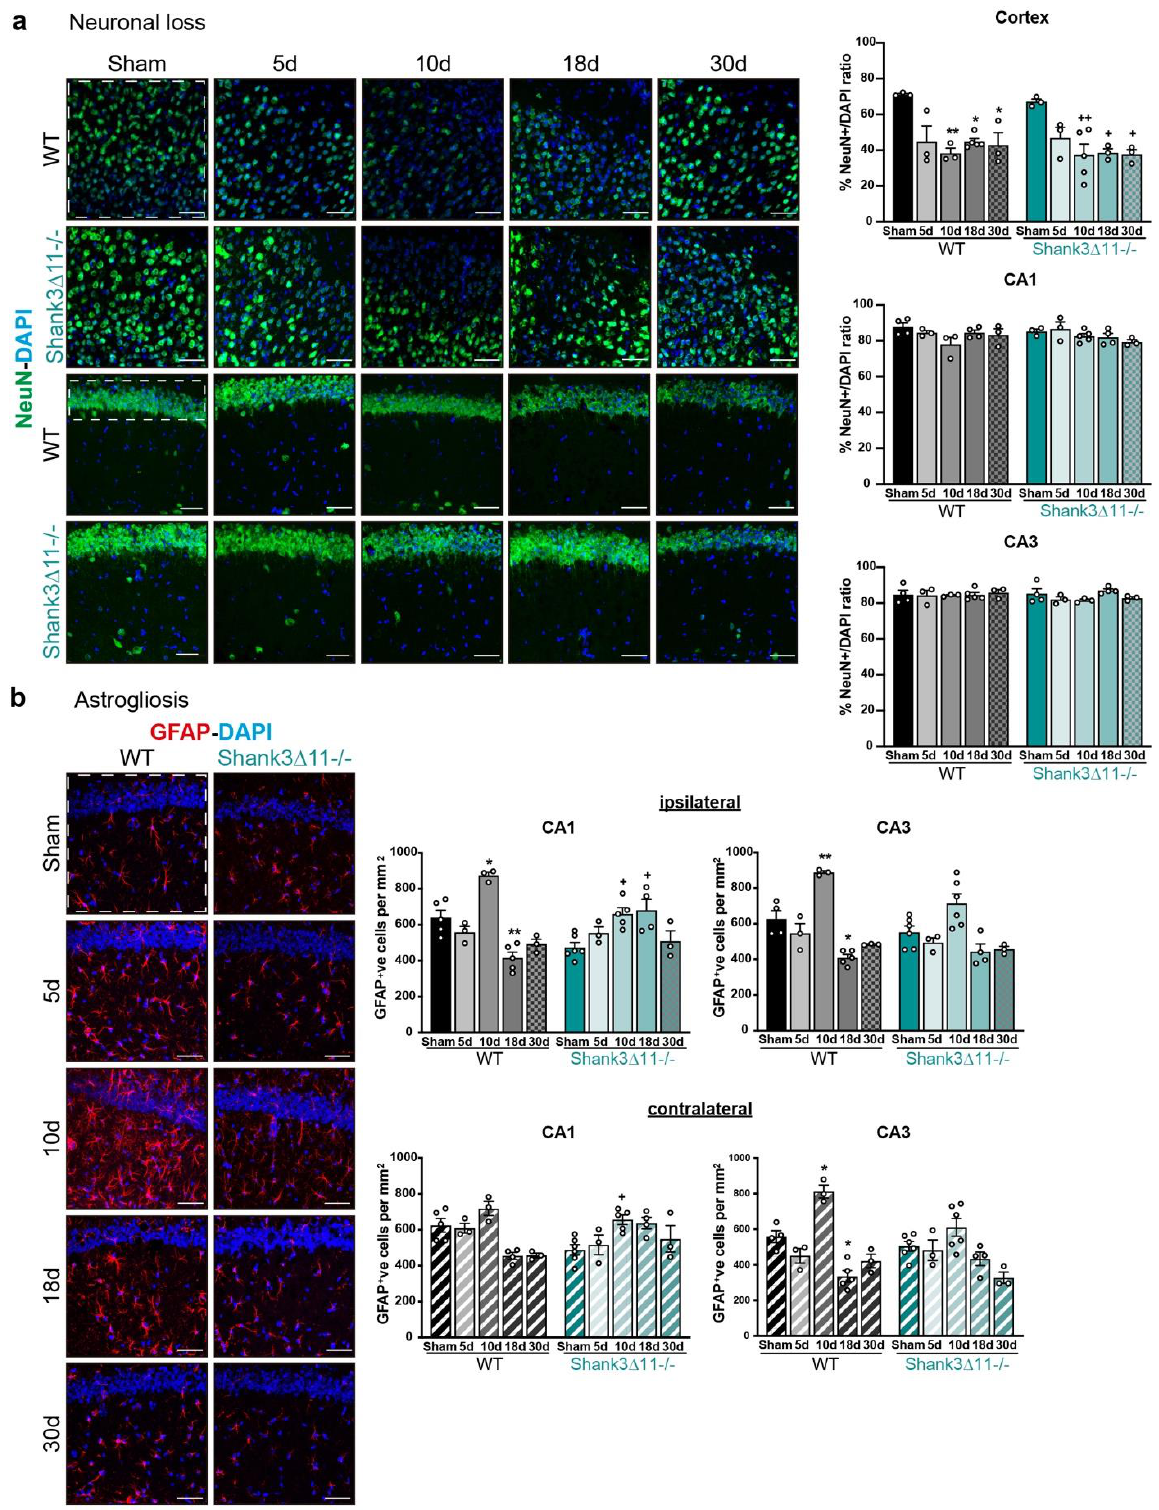
Figure 3. mTBI triggers no hippocampal neuronal loss and prompts astrocyte proliferation in both wild-type and Shank3 ∆ 11-/- mice. ( a ) Neurons were stained with the neuronal nuclear marker NeuN (green) and with DAPI (blue) on the brain ipsilateral cortex, CA1 and CA3 hippocampal region. Representative images (scale bar 50 μ m) for the ipsilateral cortex (left first and second rows) and for the CA1 ipsilateral hippocampus (left third and fourth rows) of WT (first and third rows) and Shank3 ∆ 11-/- mice (second and fourth rows). The white dashed square/rectangle represents the re- gion quantified. The NeuN percentage of positive nuclei quantification per field is shown for the